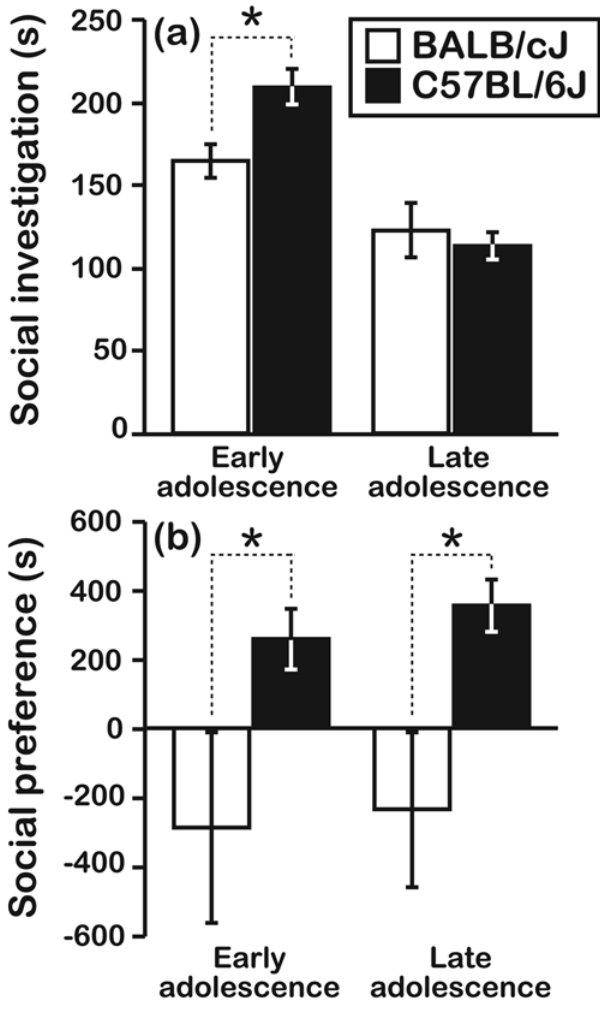
Figure 10. Strain-dependent development of sociability in adolescent mice. (a) Following 24 h of social isolation, early- adolescent (age = < 4 wks) B6 test mice expressed more social investigation (SI) towards a novel, opposite-sex F1 mouse compared to age-matched BALB mice. There was no difference in SI among late- adolescent mice (age=7–8 wks) from the BALB and B6 strains (N=14 mice/genotype/age). The numeric symbol represents a significant (P=0.01), planned orthogonal contrast between BALB and B6 mice. (b) Following 8 days of conditioning during early adolescence or late adolescence, B6 mice expressed a social conditioned place preference (SCPP), whereas BALB mice expressed social indifference at both time points (N=14 mice/genotype/age). SCPP scores were calculated by subtracting the time a mouse spent in an isolation-paired environment from the duration it spent in a socially paired environment (see Materials & Methods). The asterisks represent significant (P , 0.05), planned orthogonal contrasts between BALB and B6 mice. All data are presented as the mean 6 s.e.m.